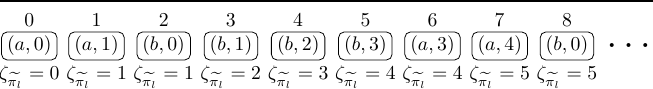
Figure 2. An example of the